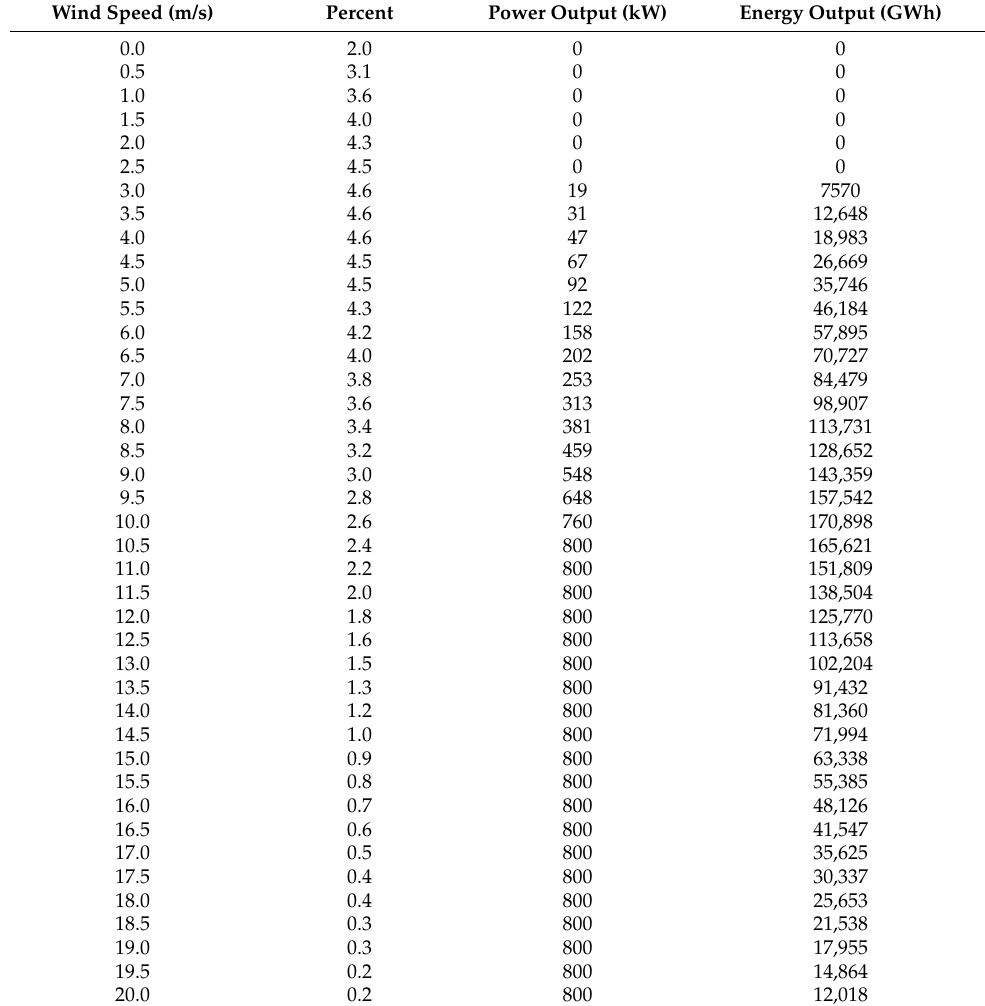
Table A2. Annual Energy Production Calculation for Ati,